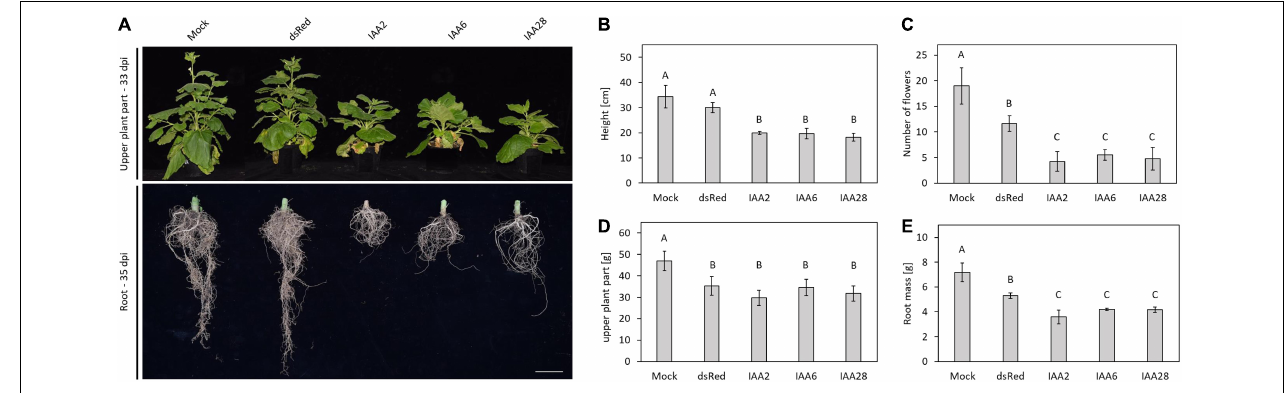
FIGURE 7 | Heterologous expression of Aux/IAAs in N. benthamiana . (A) Upper plant part and root phenotypes of N. benthamiana , non-inoculated (mock), mechanically infected with TRV expressing dsRed, IAA2, IAA6, and IAA28. Pictures of the upper plant part were taken at 33 dpi and pictures of the root phenotype were taken at 35 dpi. Scale bar, 5 cm. The examinations of different plant parts are shown on the right. (B) Plant height in cm, (C) number of flowers, (D) mass of the upper plant part in g, (E) mass of the root in g. Data and error bars represent the mean and the standard deviation of at least four replicates ( n = 4). Significant differences are indicated as letters above the